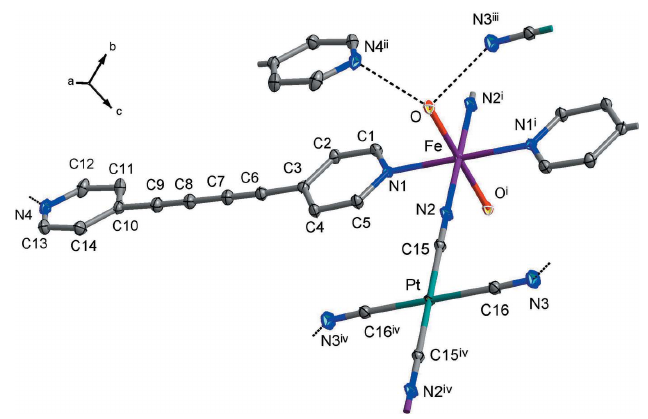
Figure 1 A fragment of the structure of the title compound showing hydrogen bonds with adjacent polymeric chains (dashed lines). [Symmetry codes: (i) (cid:2) x , 1 (cid:2) y , (cid:2) z ; (ii) 2 (cid:2) x , (cid:2) y , (cid:2) 1 (cid:2) z ; (iii) (cid:2) x , 1 (cid:2) y , (cid:2) z ; (iv): (cid:2) x , (cid:2) y , (cid:2) z .]